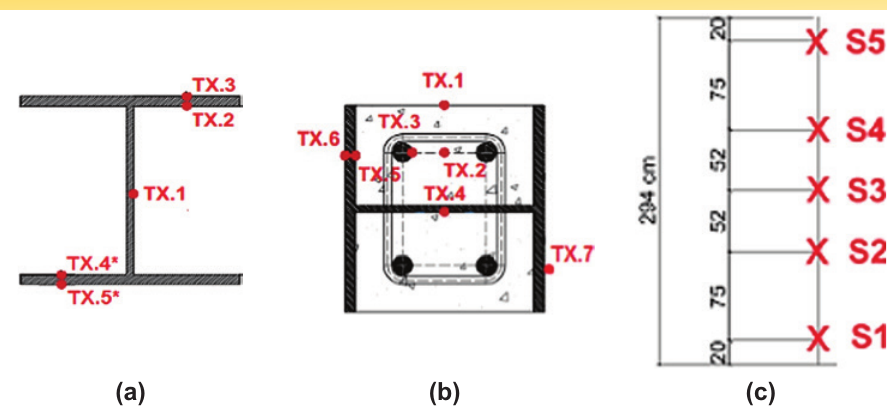
Instrumentação do ensaio experimental: a) Pilar de aço; b) Pilar misto; c) Indicação das seções em que foram medidas as temperaturas (Rocha